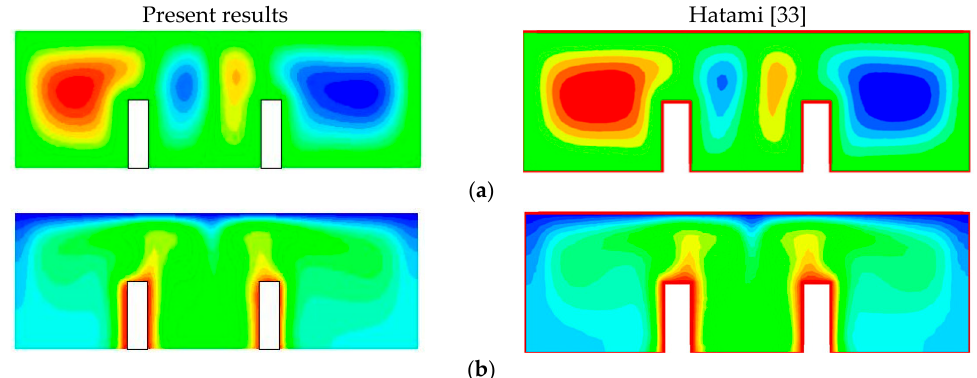
Figure 2. Grid study at 𝜙 (cid:3002)(cid:3039) and 𝛾 = 0.1 .